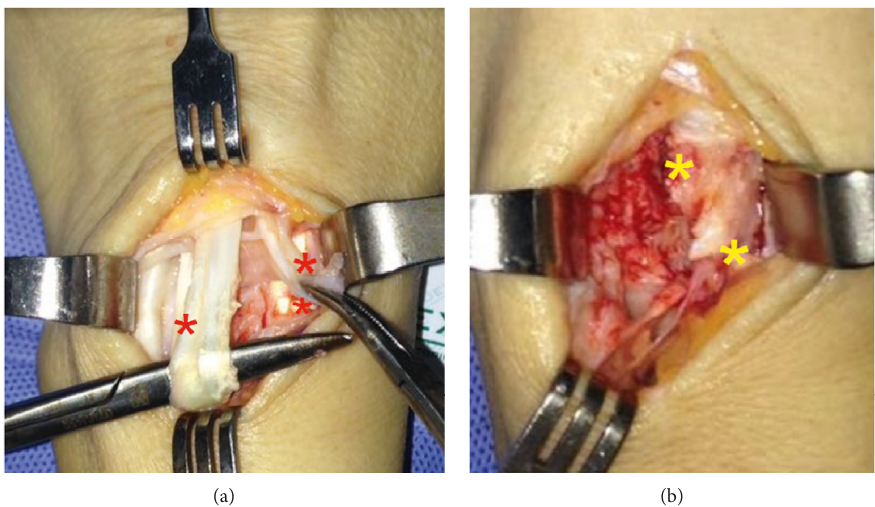
Figure 4: EDC laceration and EIP rupture (a). Dorsal exostoses